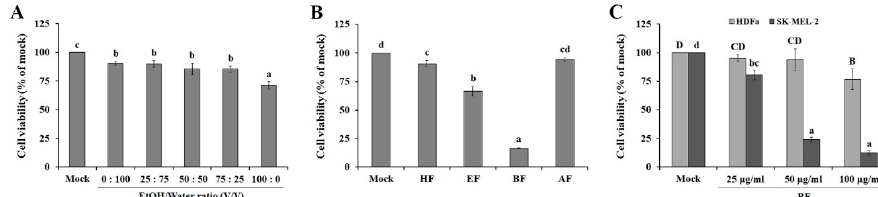
Figure 1. Anti-melanoma activities of Sorbus commixta fruit extracts. ( A ) Cytotoxic effects of ethanol concentration on SK-MEL-2 cells. ( B ) Effect of solvent fractions of Sorbus commixta fruit ethanol extract on anti-melanoma activity. SK-MEL-2 cells were treated with 100 μ g/mL of each extract or solvent fraction. After incubation for 48 h, cell viability was determined via the MTT assay. ( C ) Dose-dependent effect of butanol fraction (BF) on the viability of SK-MEL-2 cells and HDFa human dermal fibroblast adult cells. Dimethyl sulfoxide (DMSO) treated samples served as mock. Values with different letters were found to be significantly different ( p < 0.05). Values are reported as the mean ± SE. Hexane fraction, HF; ethyl acetate fraction, EF; butanol fraction, BF; aqueous fraction, AF.